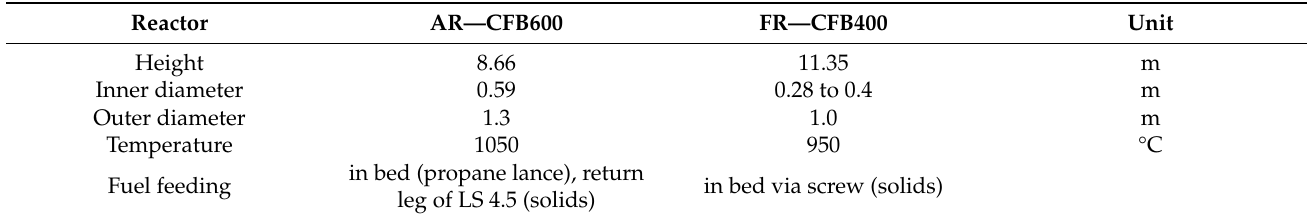
Table 1. Reactor properties of the 1MW CLG pilot